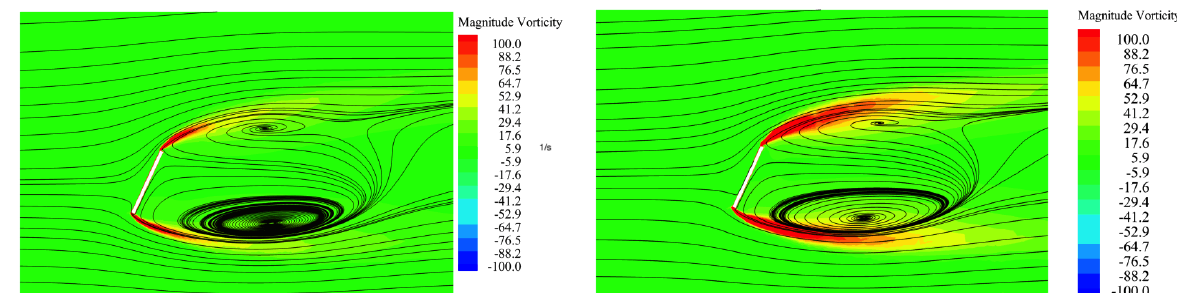
Figure 3. Vorticity map from preliminary numerical studies: 5 m/s on the left and 10 m/s on the right.